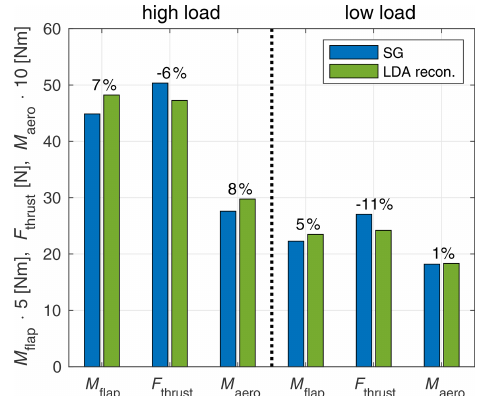
Figure 20. Comparison of the steady load levels for high and low loads for the integral turbine loads M flap , F thrust and M aero obtained by strain gauges and reconstructed from LDA